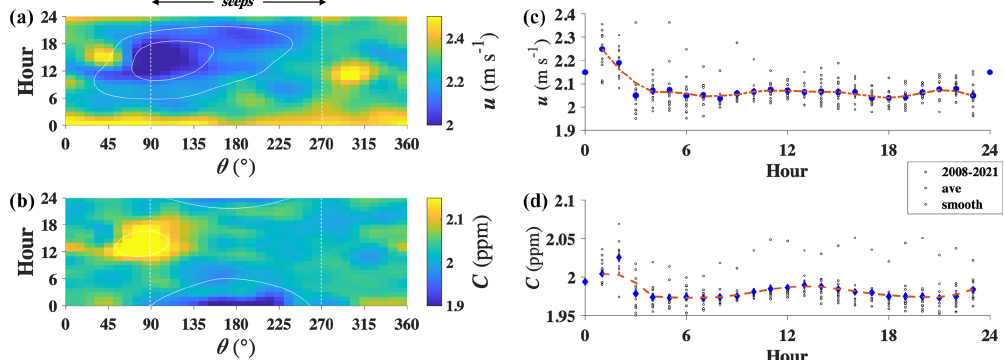
Figure 6. (a) The 2008–2021 hour and wind direction, θ , resolved wind speed, u , and (b) concentration, C . (v) Hourly-resolved seep direction (90–270 ◦ ), wind speed, u , and (d) concentration, C , averaged for individual years and 3-year smoothed. Data key is shown in the figure. Midnight data are missing due to daily calibration.